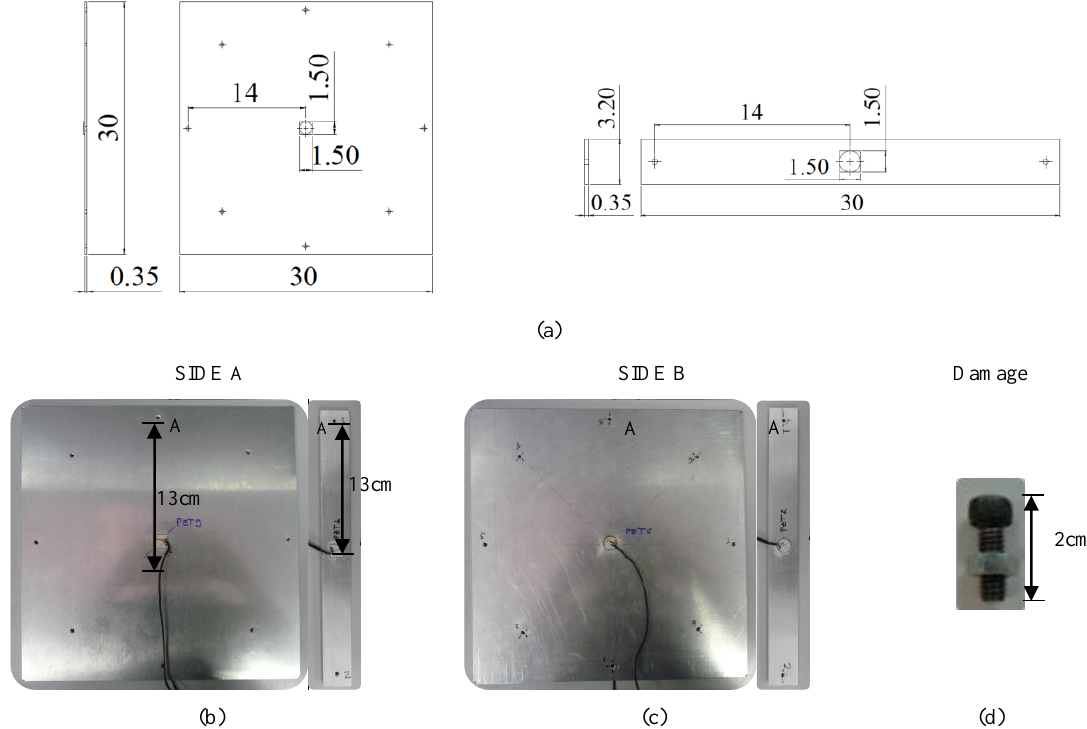
Fig. 2. (a) Geometry of the plate and beam; (b) Side A of the plate and beam; (c) Side B of the plate and beam; (d) Mass added to the